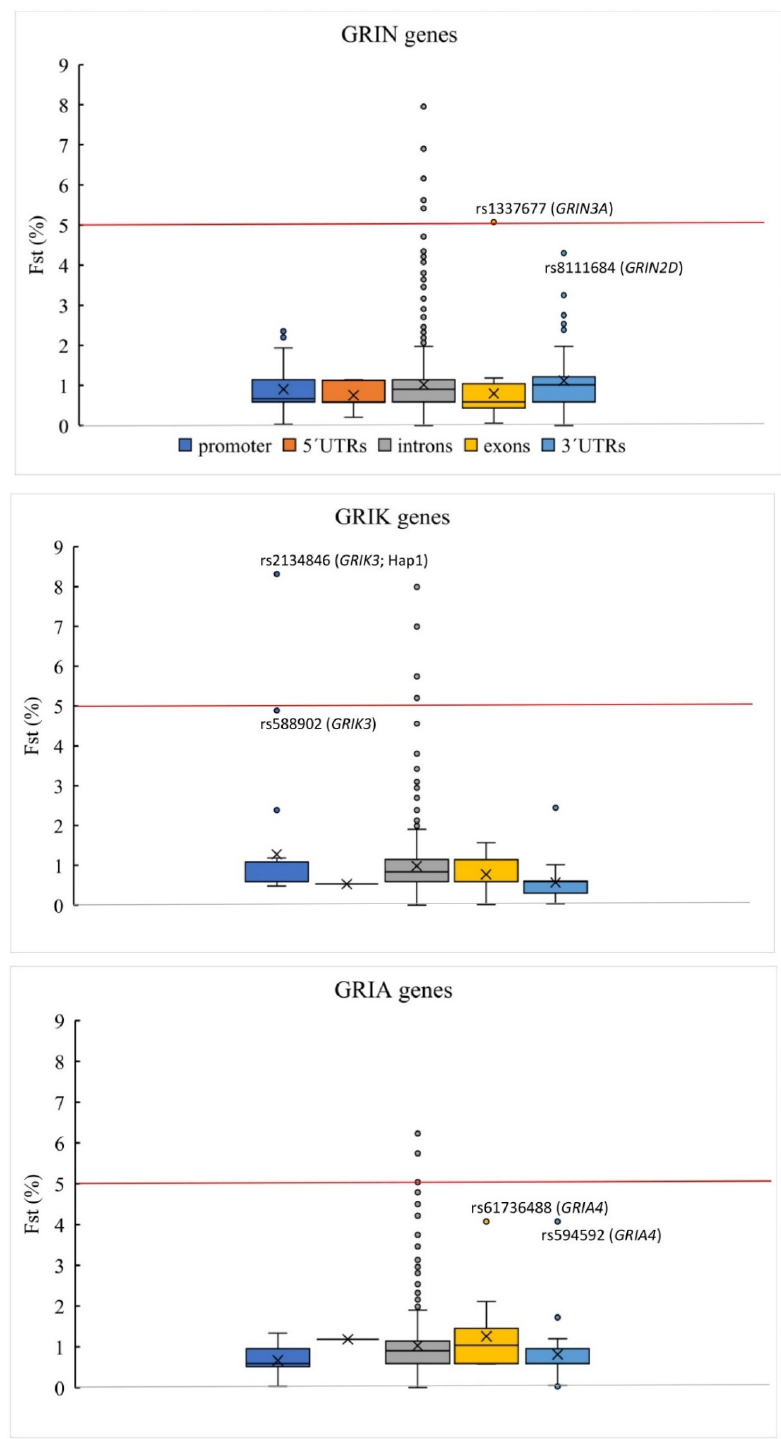
Figure 2. The Fst (%) estimate for variants detected in iGluR genes. Boxplots show variants with Fst above 5% (last percentile of the Fst distribution) that are located nearly exclusively in intronic sequences. Non-intronic variants are highlighted. The rs61736488 is a synonymous substitution p.Lys798Lys from exon 15 of GRIA4 with a medium CADD_phred score of 10.66. The variant rs594592 is located in the 3 (cid:48) UTR of GRIA4 with a low CADD_pherd score of 1.841. The GRIK3 promoter variant rs2134846 is part of the haplotype Hap1. Another GRIK3 promoter variant rs588902 with a high CADD_phred score of 22.3 is highly conserved and has the GERP score of 2.51. The exonic variant rs1337677 is a synonymous variant p.Pro229Pro from the first exon of GRIN3A that is in almost complete linkage with the haplotype Hap4 and has a medium CADD_phred score of 11.62. The GRIN2D 3 (cid:48) UTR variant rs8111684 has a CADD_phred score of